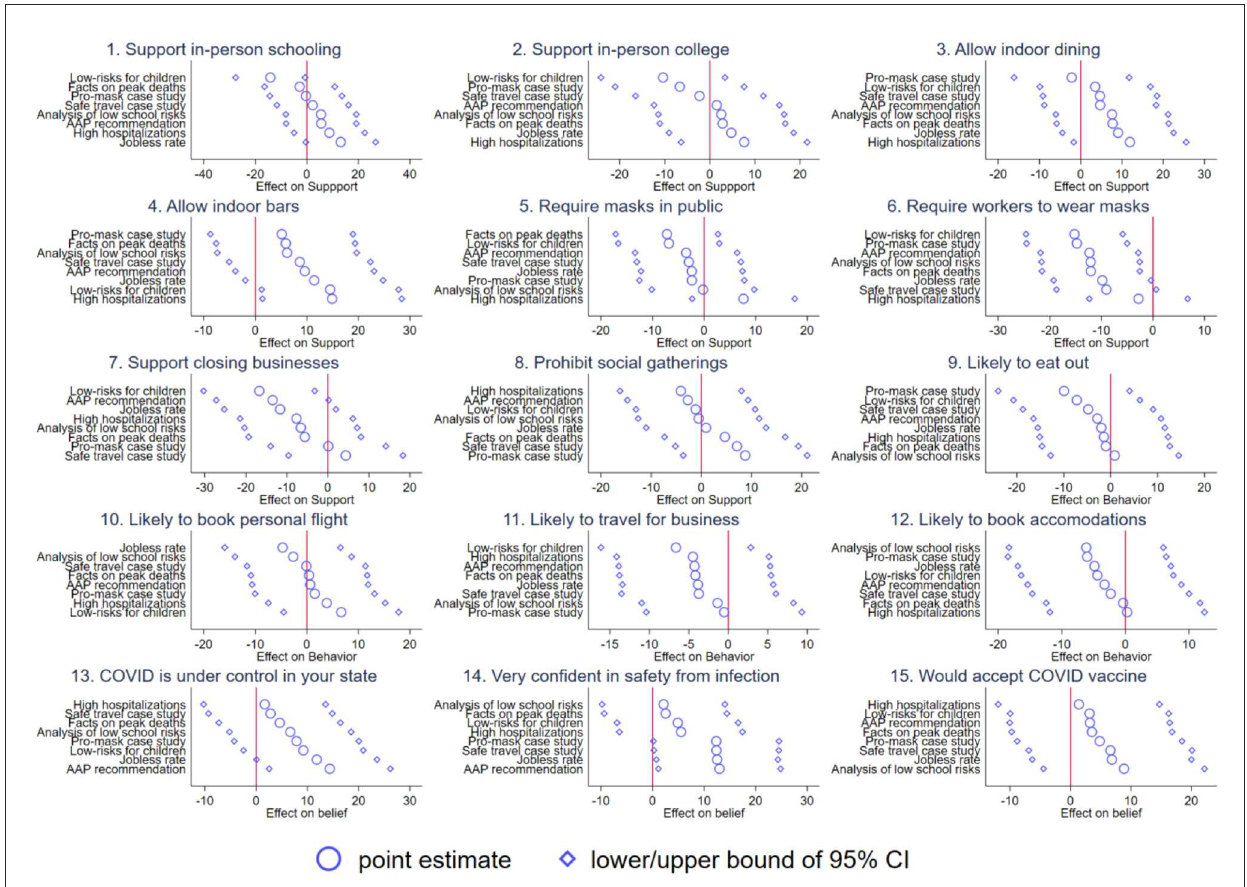
FIGURE3 Treatment effects of democratic party members relative to Republican Party Members. Each figure plots treatment effects for respondents identifying as Democrats relative to Republicans. 95% confidence intervals are